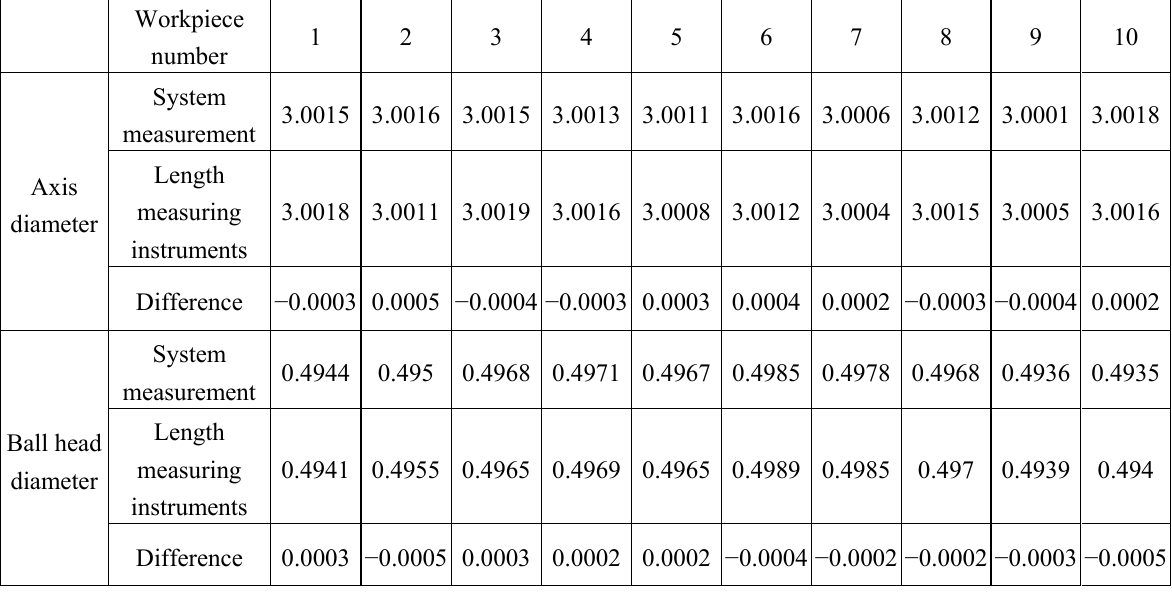
Table 3. Measurement results of axis diameter and ball head diameter